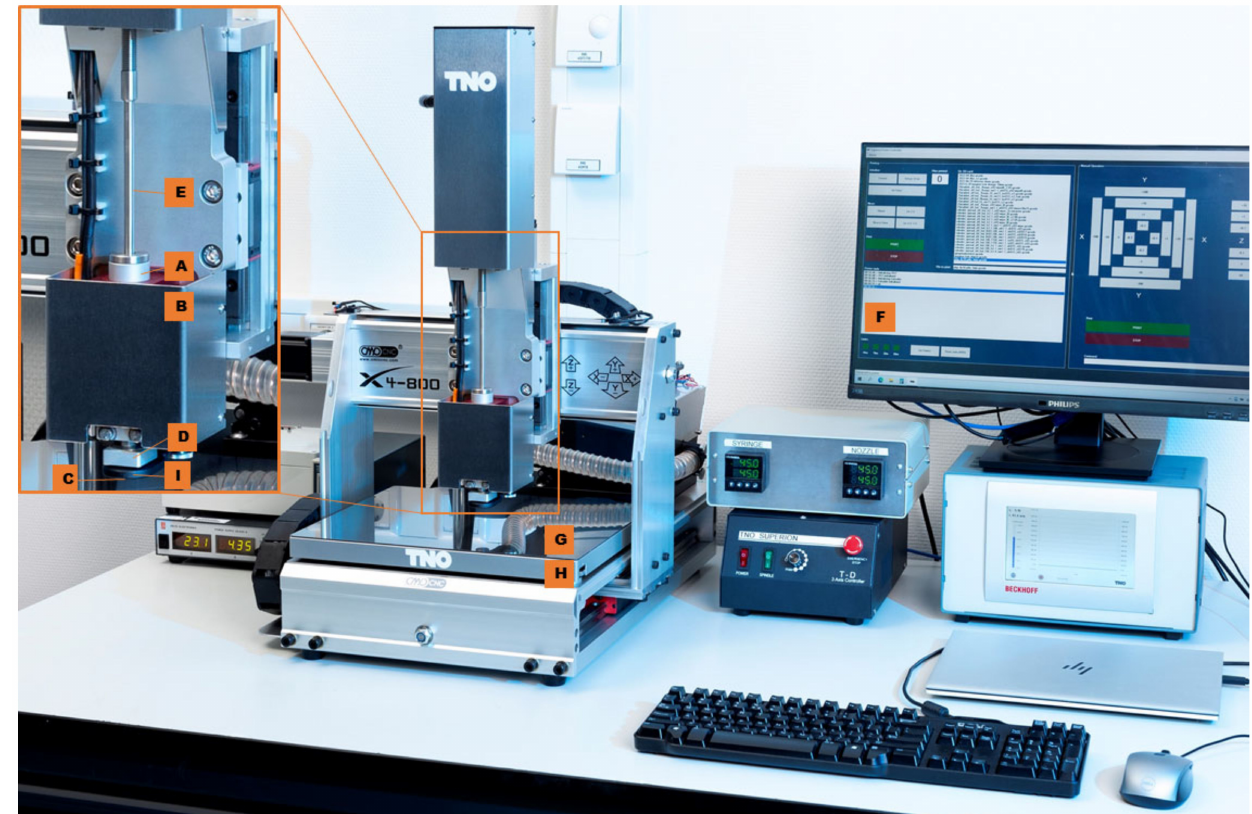
Figure 2. Used printer setup; syringe ( A ), the heating element of the syringe ( B ), nozzle ( C ), the heating element of the nozzle ( D ), piston ( E ), computer with Pronterface ( F ), printing platform ( G ), heating bed ( H ), and cooling ( I